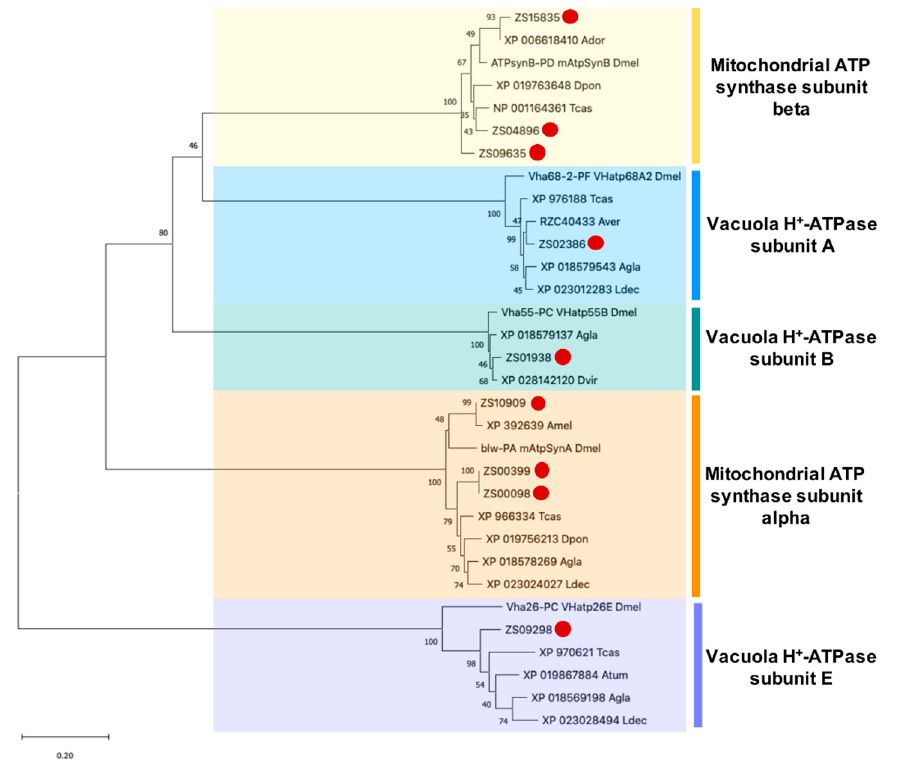
Figure 6. Phylogenetic analysis of putative ATP synthase subunit and V-type H + -ATPase proteins of Z. subfasciatus and other species. The phylogenetic tree was generated by MEGA X using the neighbor-joining method with 1000 bootstrap replicates. The accession number or symbol gene is shown. Amino acid sequences from other species used for comparison: Atum ( Aethina tumida ), Agla ( Anoplophora glabripennis ), Ador ( Apis dorsata ), Amel ( Apis mellifera ), Aver ( Asbolus verrucosus ), Dpon ( Dendroctonus ponderosae ), Dvir ( Diabrotica virgifera virgifera ), Ldec ( Leptinotarsa decemlineata ), Tcas ( Tribolium castaneum ), Dmel ( Drosophila melanogaster ). The proteins were clustered into mitochondrial ATP synthase subunits alpha and beta, and vacuola H + -ATPase subunit A, B and E groups. Colored boxes represent proteins belonging to the same group. Putative targets for PF2 lectin are identified by a red dot. The scale bar represents the branch